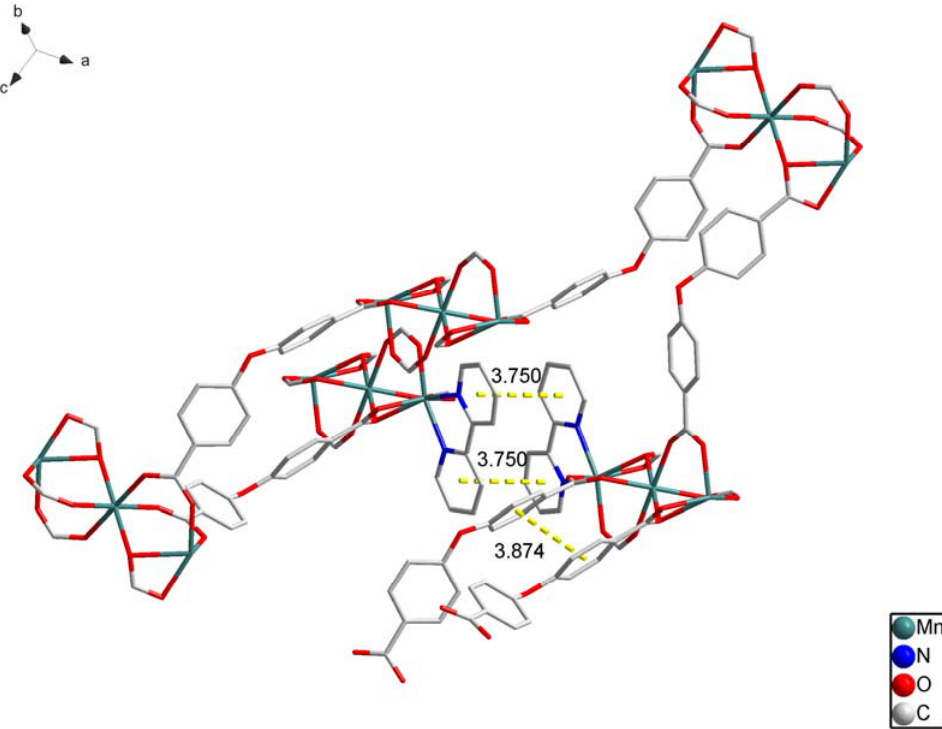
Figure 2. The π - π stacking interactions of 1 . All H atoms are omitted for